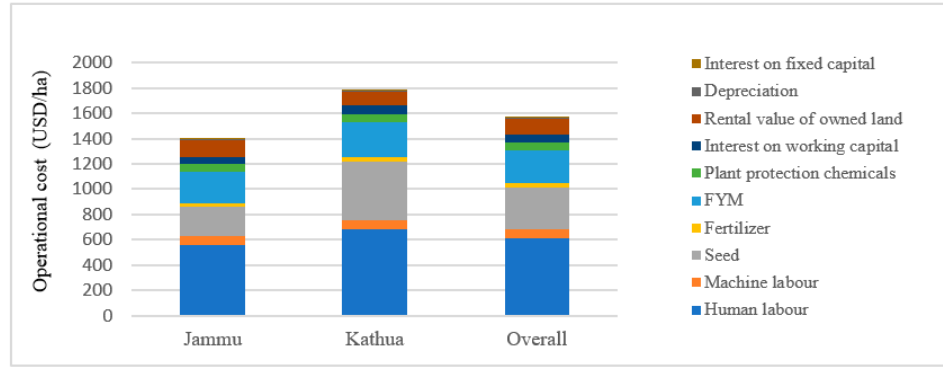
Table 2. Concept-wise cost of cultivation of marigold cultivation (USD ha − 1 ).